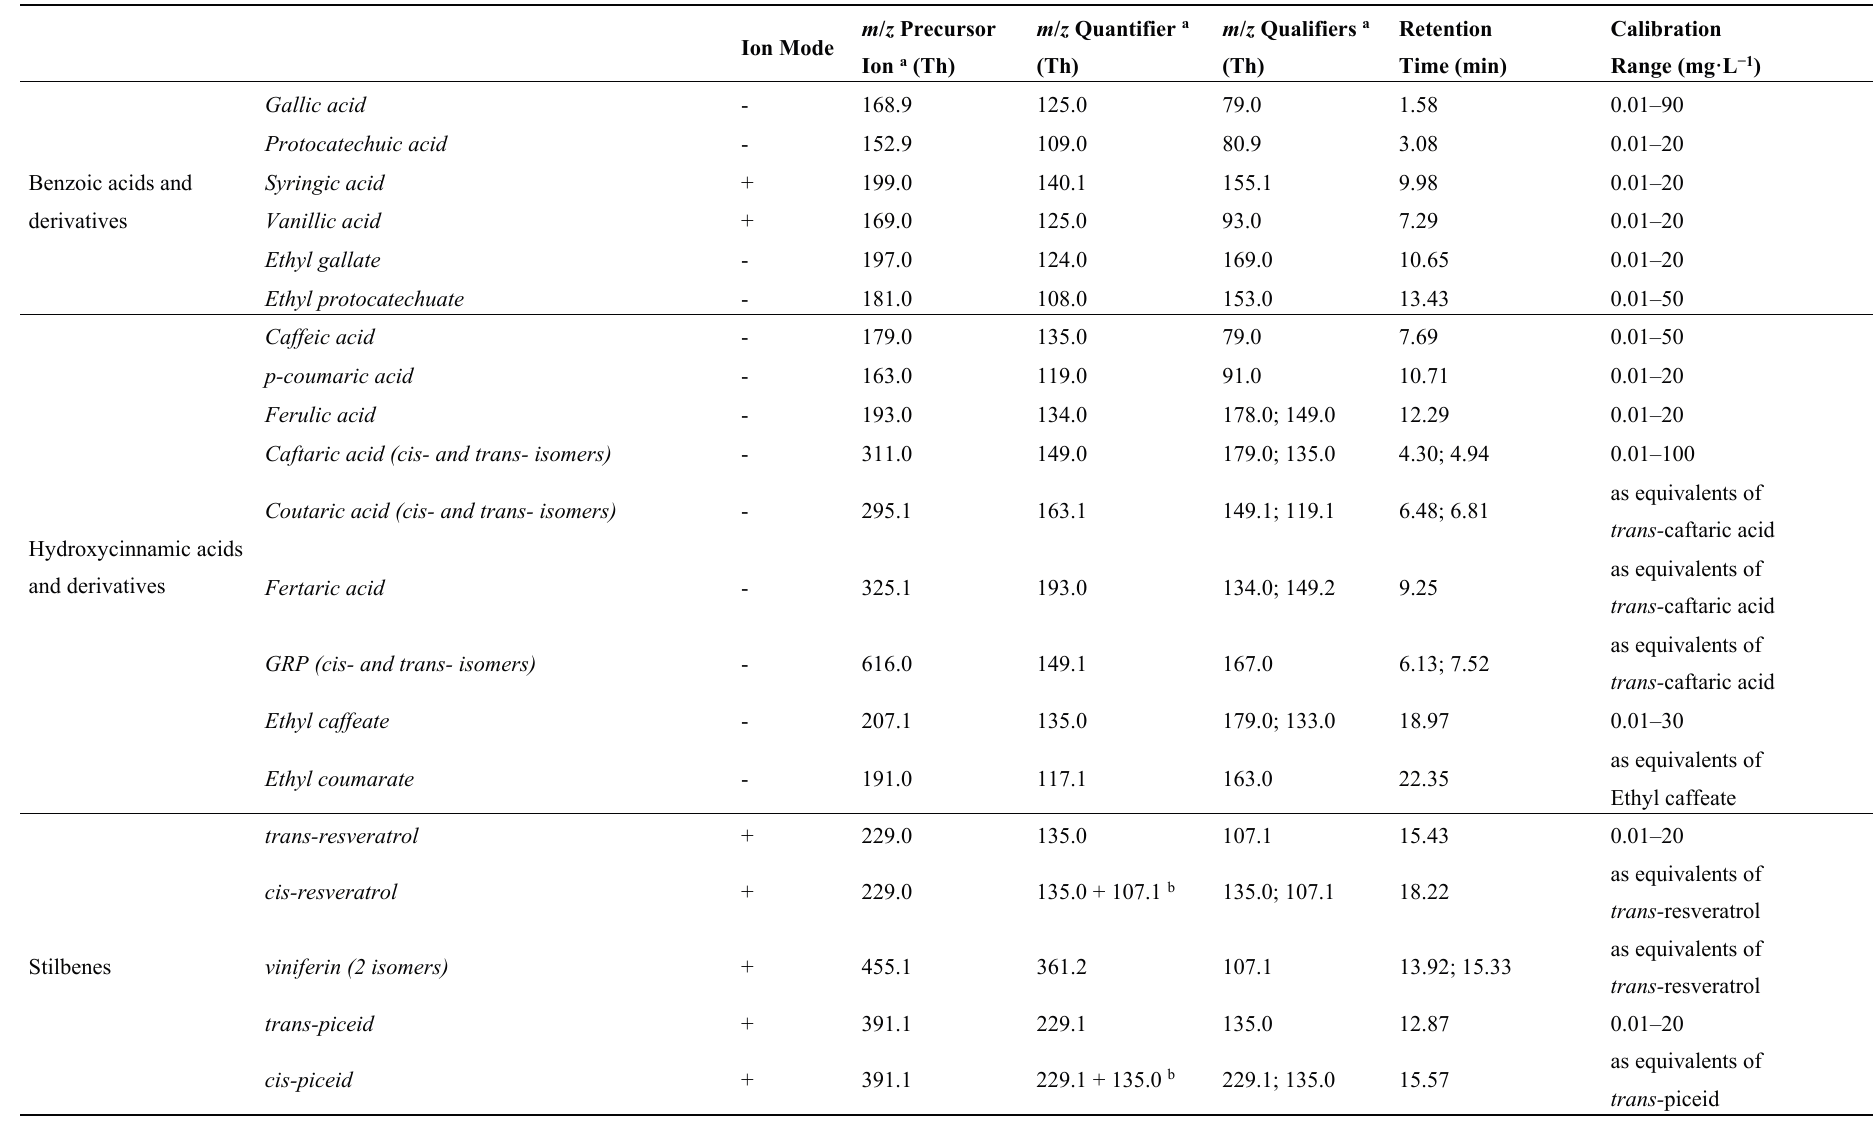
Table 1. List of quantified compounds, MRM parameters (ion mode, precursor and product ions m / z , retention times), and calibration